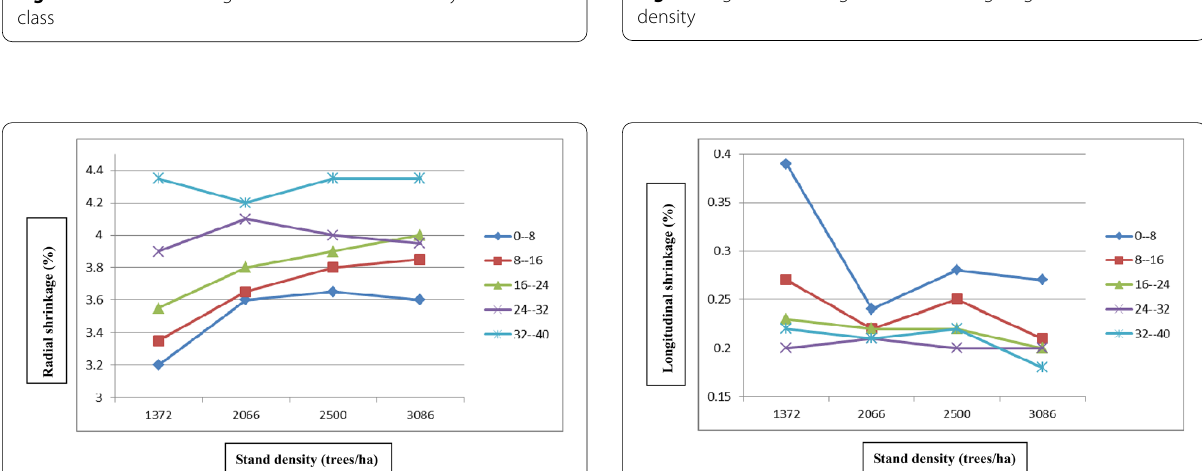
Fig. 7 Radial shrinkage in relation to log height and stand density